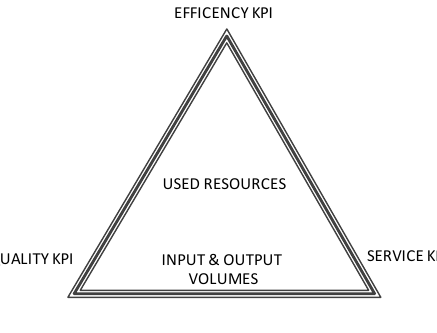
Figure 1 : Indicator Triangle